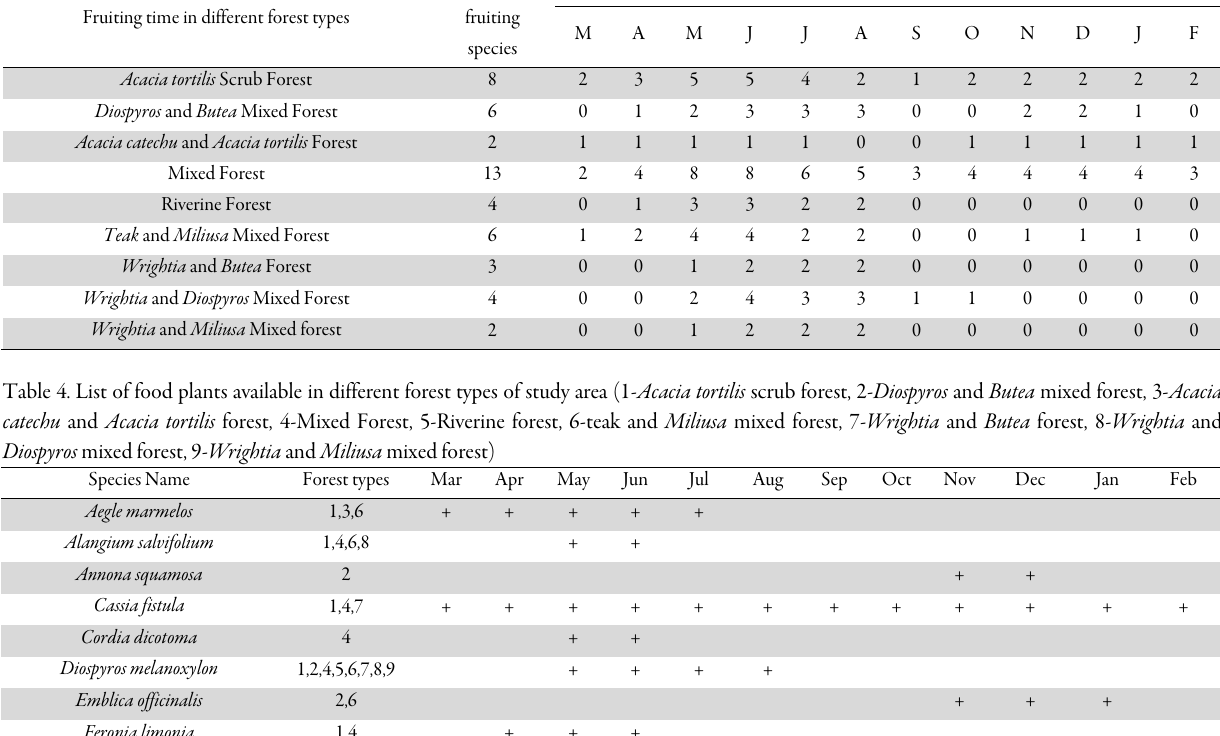
Table 3. Sloth bear food plant’s availability in the forests of Danta and BAWLS (Months from March to February) No. of Fruiting time in different forest types